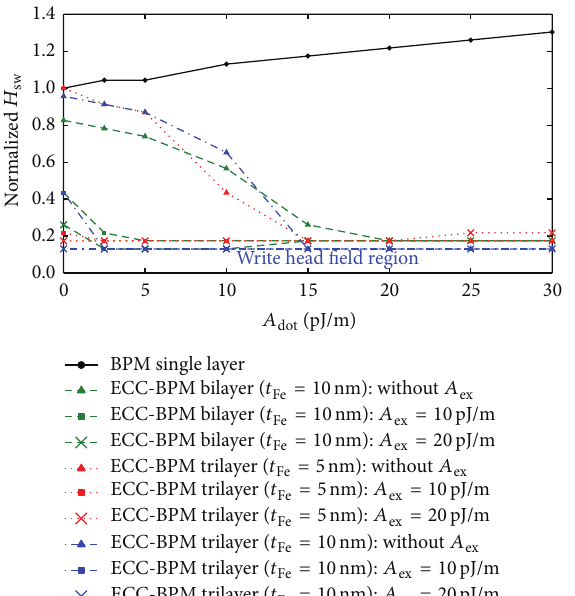
Figure 3: Dependence of normalized 𝐻